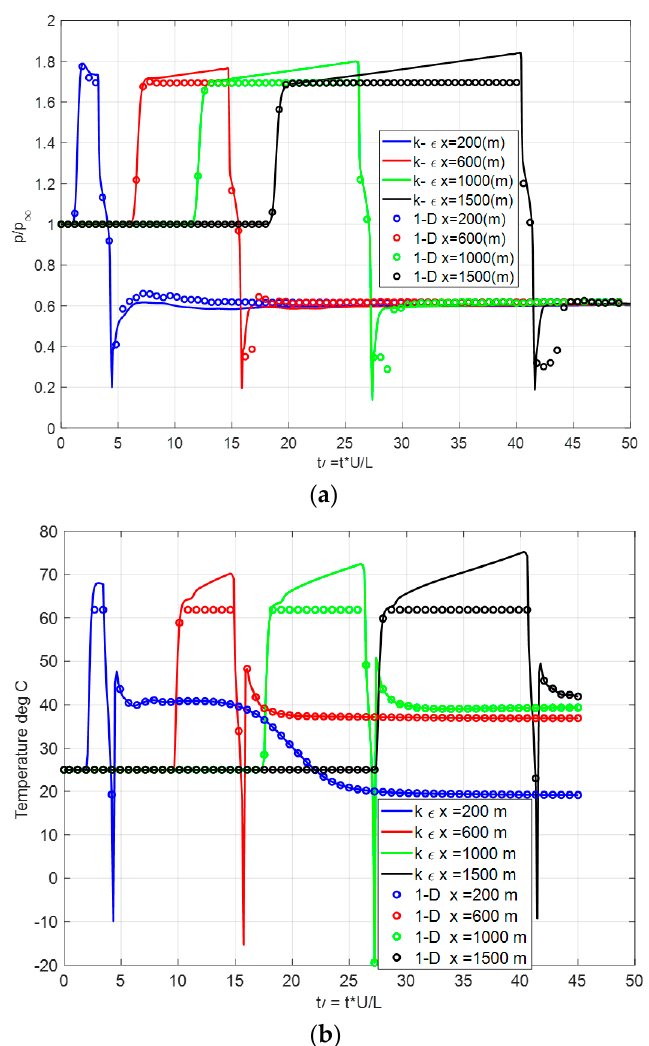
Figure 11. ( a ) Pressure ratio, ( b ) temperature history reported at x = 200, 600, 1000, 1500 (m) 𝛽 (cid:3404)